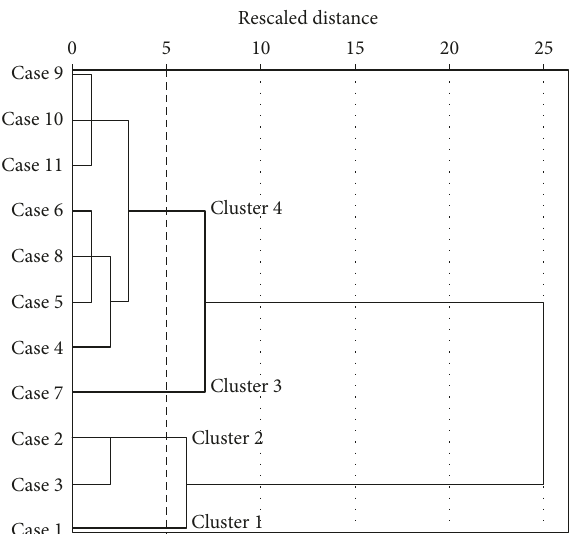
Figure 5: Clusters of the 11 sampling stations located along the coastline of southwestern